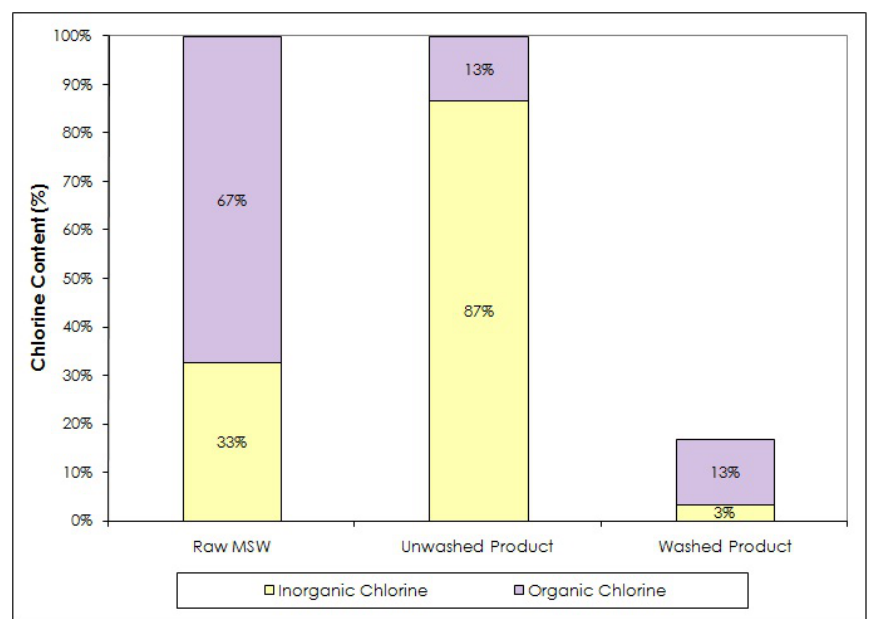
Figure 5. Chlorine contents of raw MSW and the hydrothermal products before and after the washing process.